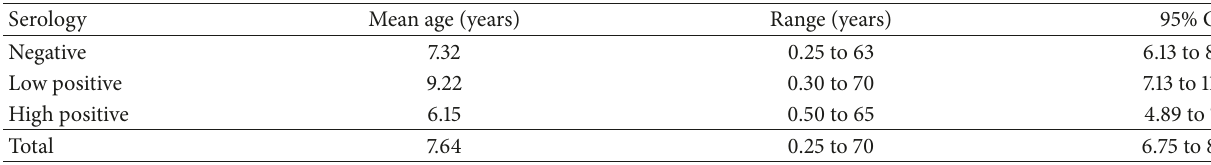
Table 4: Description of the study population by serology and mean age.